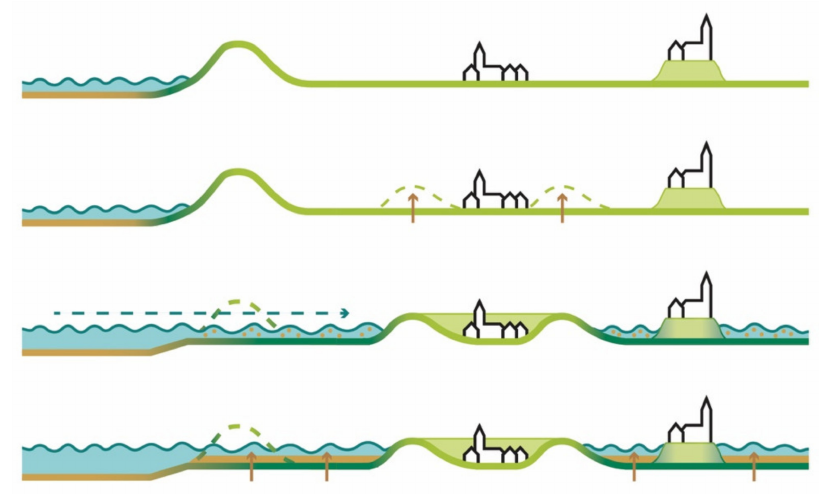
Figure 16. Raising the